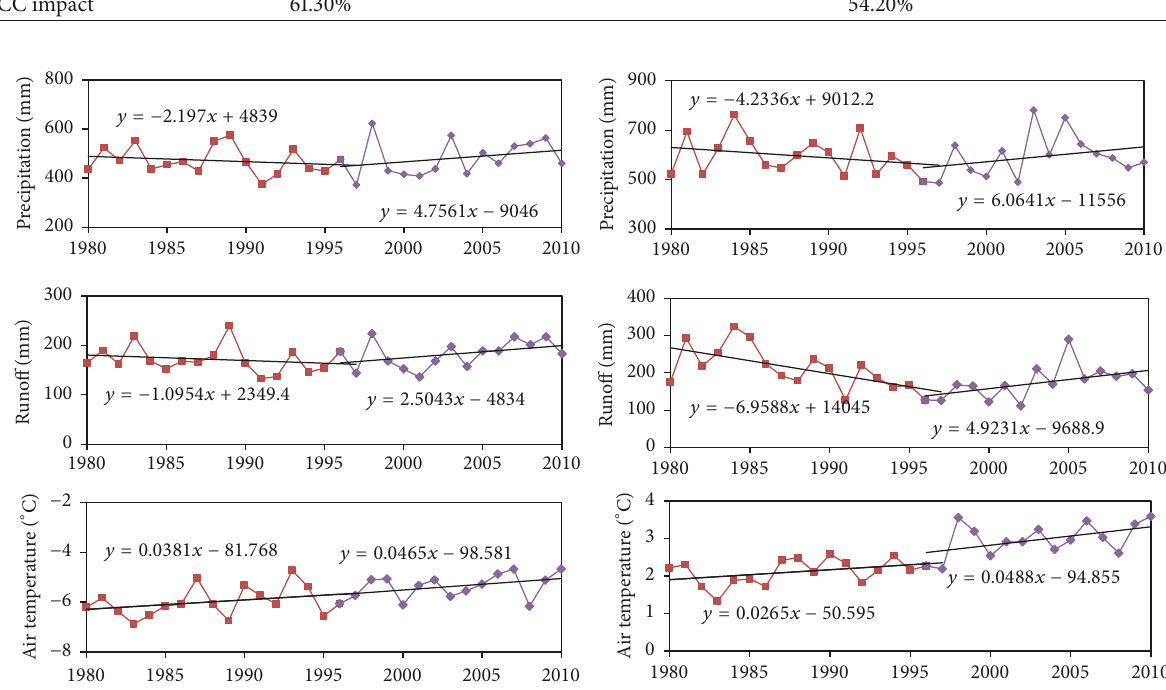
Figure 7: Temporal changes in precipitation, runoff, and temperature from 1980 to 2010, YLC to the left and MXC to the